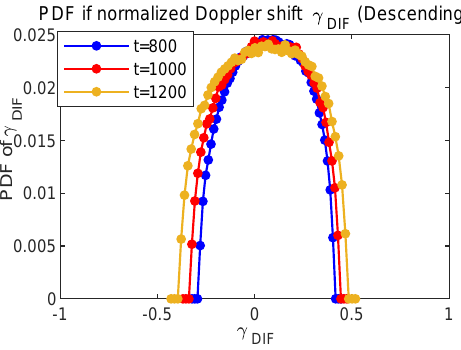
Figure 15. The PDFs of normalized Doppler shift (Cruising).